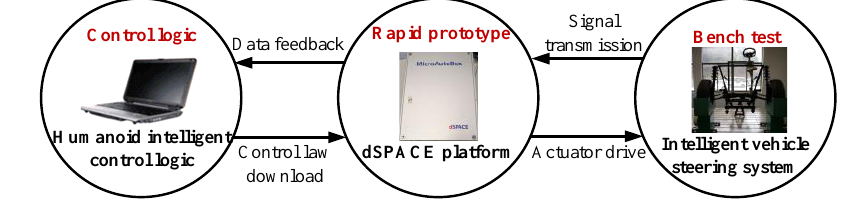
Figure 10. Implementation plans of the control system.